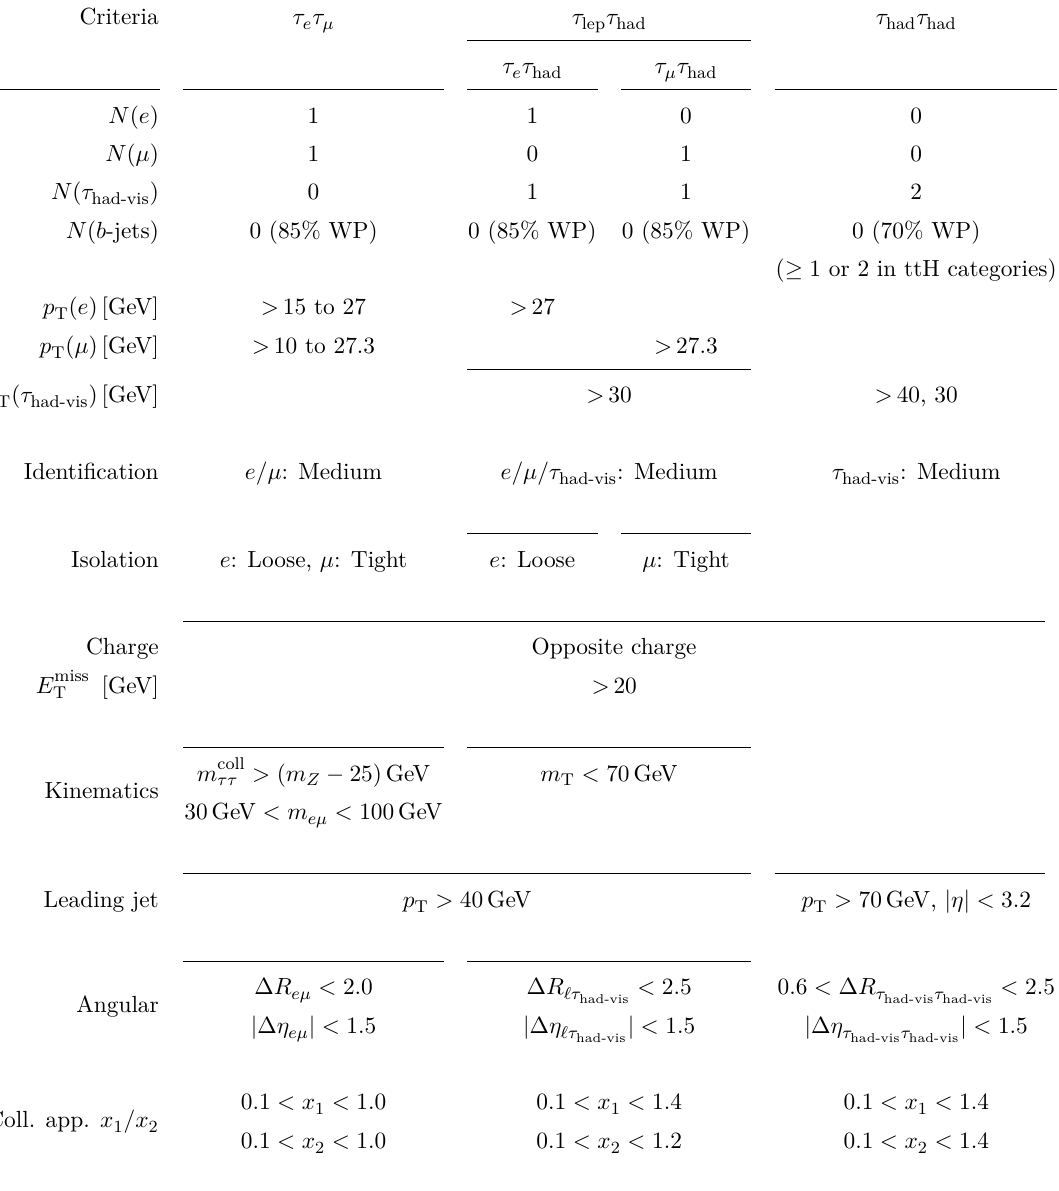
thresholds T τ had had